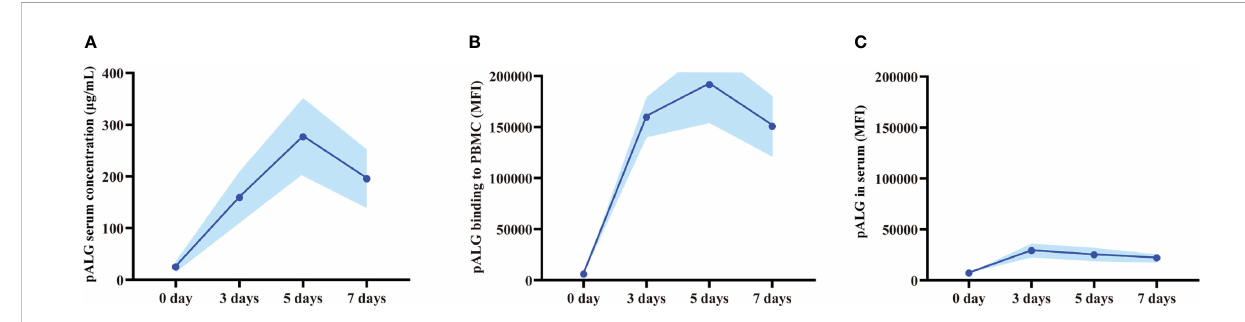
FIGURE 2 Serum pALG concentration and its binding af fi nity to PBMCs within 7 days after kidney transplantation. (A) The serum concentration of pALG. (B) The af fi nity of pALG binding to recipient PBMCs. (C) Serum pALG binding af fi nity to PBMCs from healthy volunteer. Data are expressed as mean (solid line) and SD (shaded area). PBMC, peripheral blood mononuclear